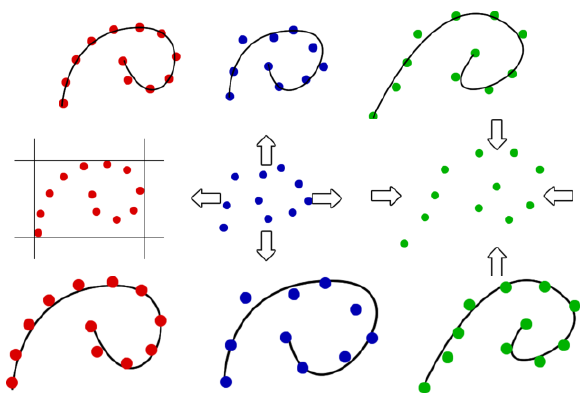
Figure 5. Redimensioning gesture repetition.